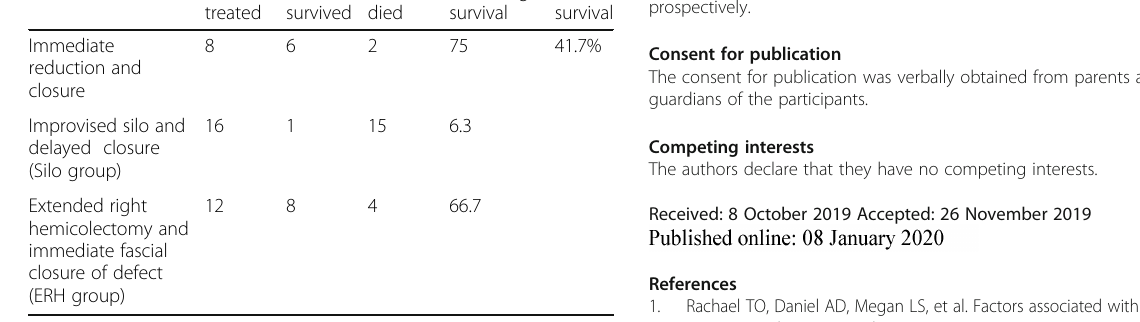
Number Number treated survived